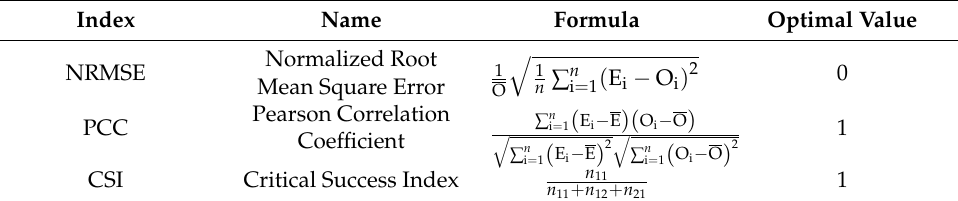
Table 3. Evaluation criteria.